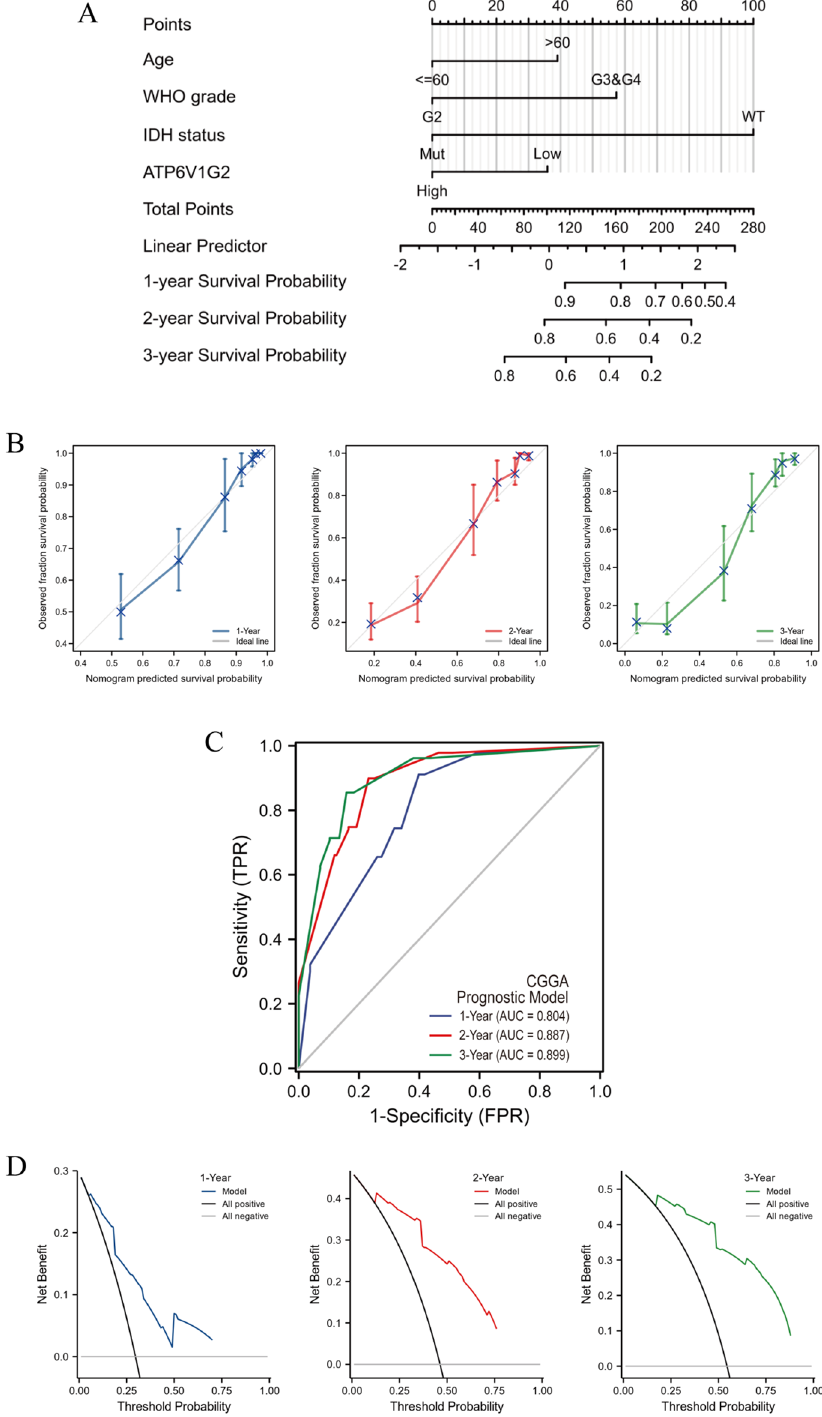
Figure 10. Visualization of the glioma prognostic model. Using the nomogram ( A ) and the calibration curve ( B ) to construct and evaluate the model in TCGA database, respectively. Using the time-dependent ROC curve ( C ) and the DCA figure ( D ) to validate the model in CGGA